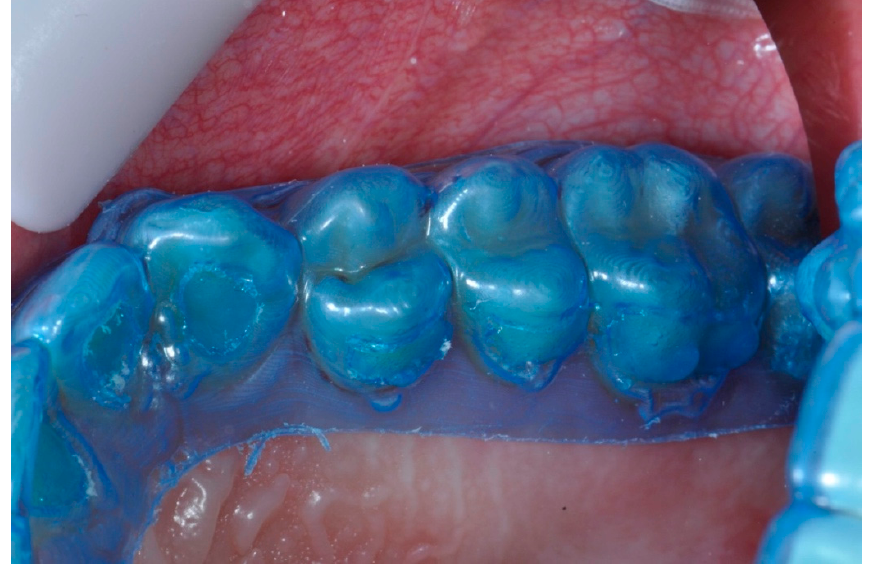
Figure 2. Etching guide in place with orthophosphoric acid at 37%.